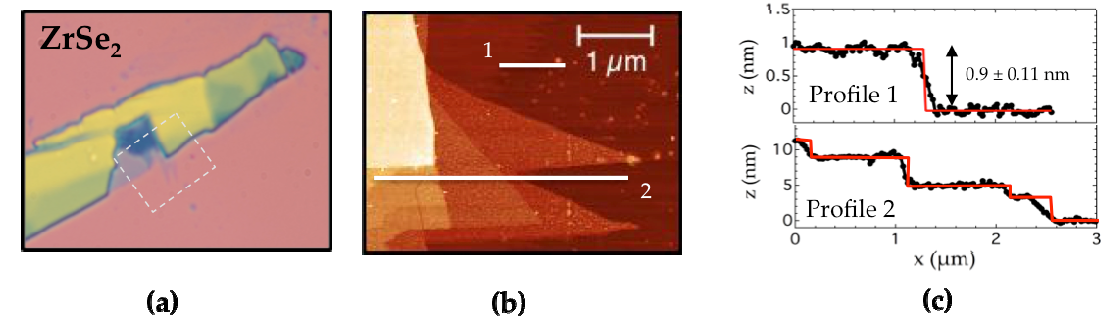
Figure B2. ( a ) Optical microscope and ( b ) AFM measurement of the dotted box in (a) with ( c ) the corresponding thickness profile for ZrSe 2 flakes.